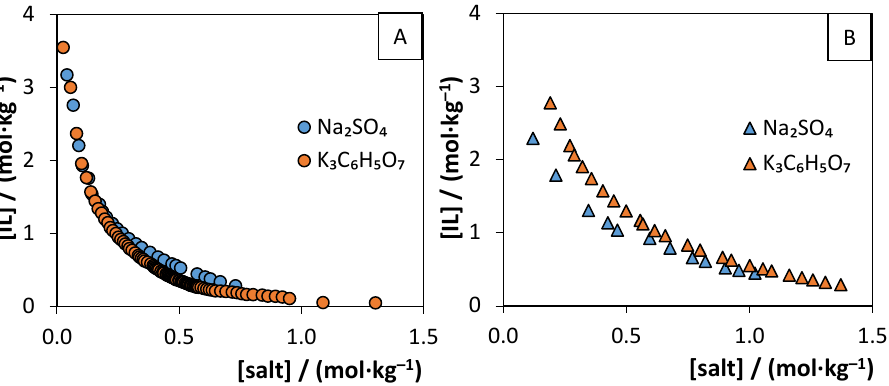
Figure 4. Binodal curves of the ternary systems, composed of ( A ) [N 4444 ][Theop] or ( B ) [N 4444 ][Theob], water, and Na 2 SO 4 (blue) or K 3 C 6 H 5 O 7 (orange) at (298 ± 1) K and atmospheric pressure (0.1 MPa).